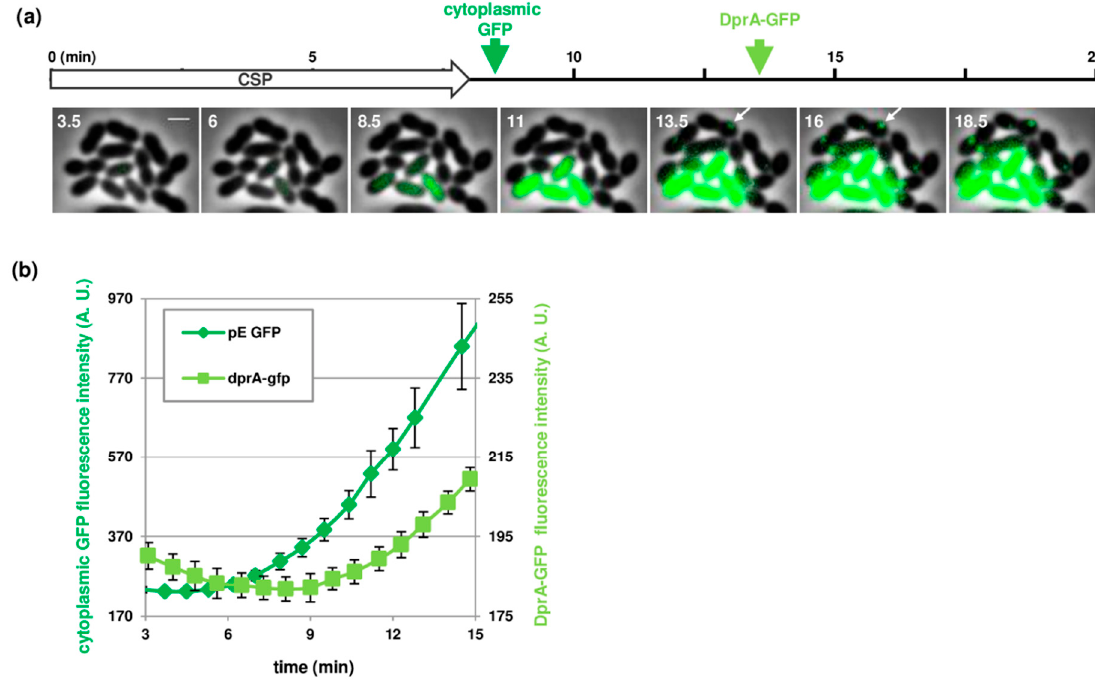
Figure 4. Comparison of the kinetics of expression of early (P E - gfp , strain R4254) and late ( dprA-gfp , strain R3728) competence genes. ( a ) Still images from time-lapse microscopy of a mixed culture containing equal densities of the two strains. Images were captured at 50 s intervals during 2 h. Every third image is shown. The starting point of the time-lapse corresponds to the beginning of CSP perfusion. Time is shown in minutes. Green Arrows indicate the initial time at which the fluorescence signal is visually detected for cytoplasmic GFP (dark green) and DprA-GFP foci (light green). Overlays between phase contrast (grey) and GFP (green) are shown. White arrows point at DprA-GFP foci; ( b ) Quantification analysis of fluorescence signal based on time-lapse microscopy images. Strains R4254 and R3728 were grown in parallel microfluidic chambers and induced to develop competence by CSP perfusion. Images were captured at 50 s intervals during 2 h. Time zero corresponds to the onset of CSP perfusion. Average fluorescence intensities per µ m 2 are shown in arbitrary units (A.U.). More than 500 cells were analyzed per time point and per experiment. Averages of three replicates are shown. Error bars show standard deviations.